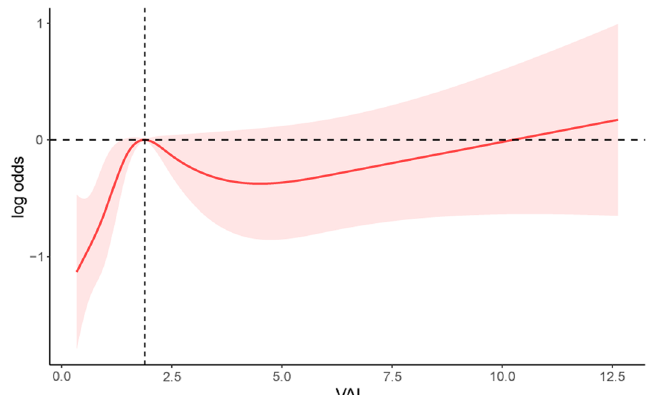
Figure 2. Density-dose–response correlation between the visceral adiposity index (VAI) and periodontitis. The light red area is indicated as the 95% CI. Each point illustrates the quantitative magnitude of the